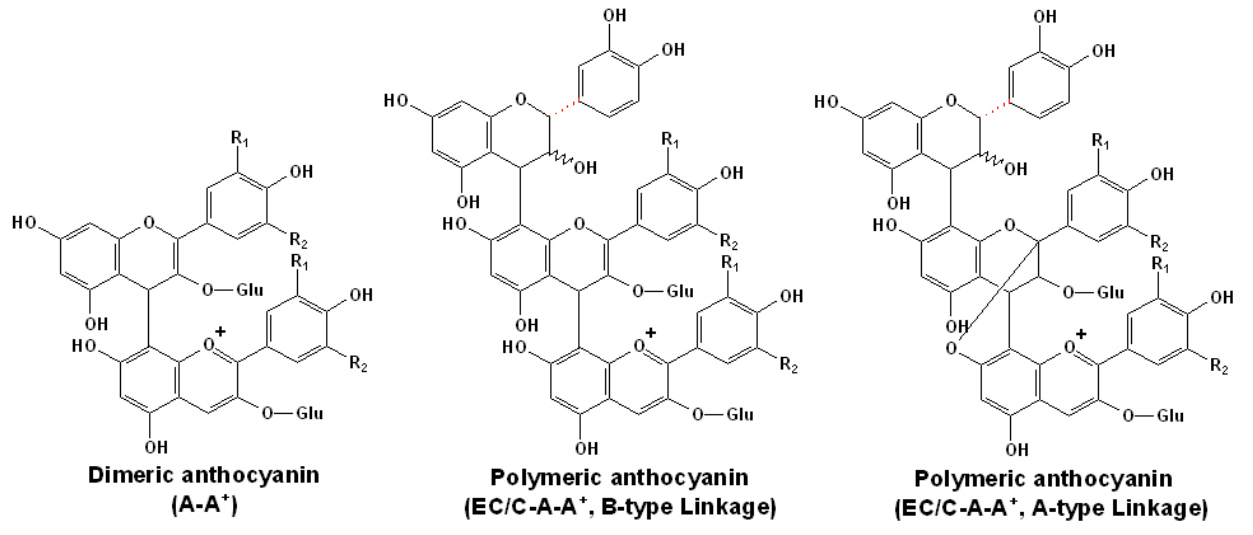
Figure 5. Structures of some directly condensed oligomeric anthocyanins [133–135].